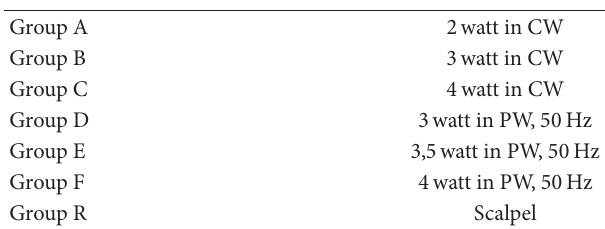
Table 1: Laser parameters.